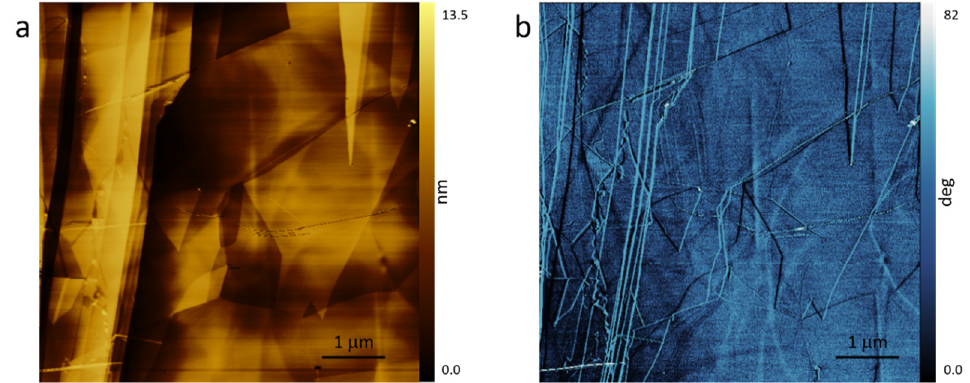
Figure 5. A (6 × 6) μ m 2 AFM image acquired on the H 2 Po 1 nm thick sample: ( a ) topography; ( b ) phase- contrast image. The HOPG substrate is exfoliated along the vertical